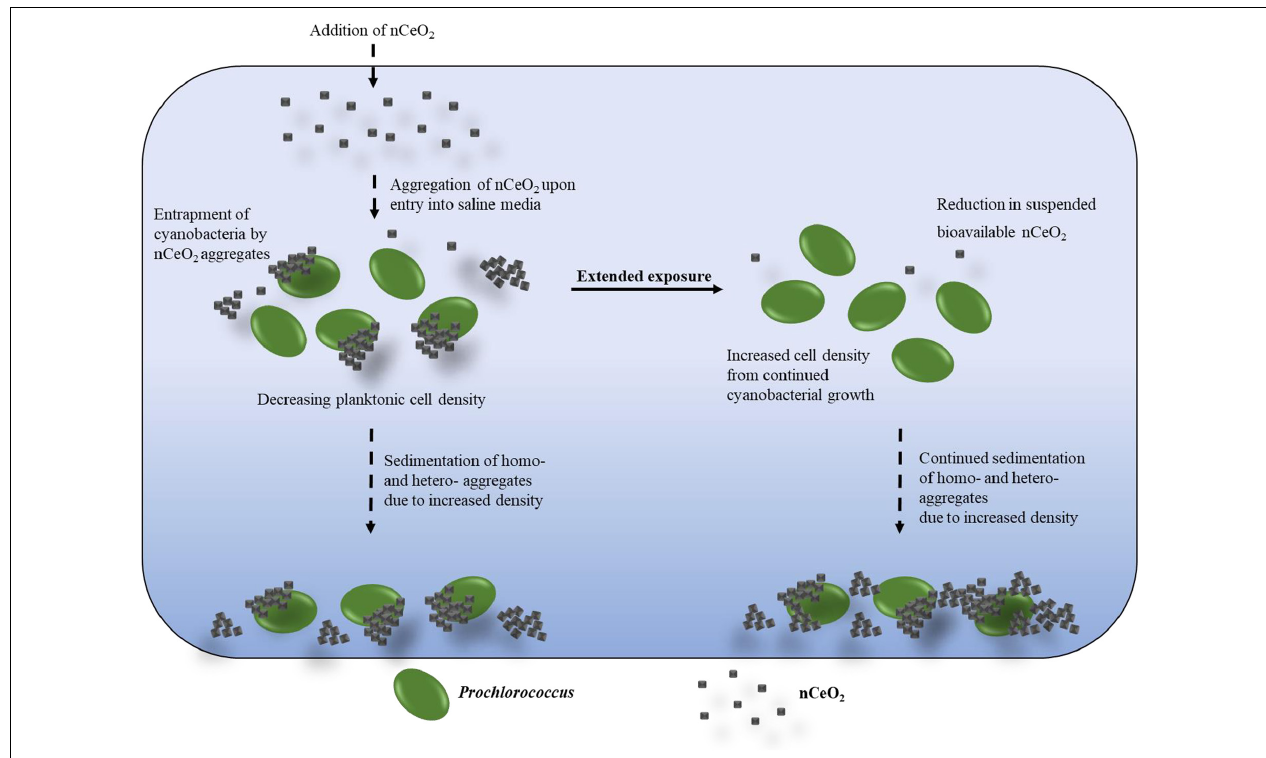
FIGURE 6 | Graphical representation of the proposed mode of cell decline recorded in exposures of Prochlorococcus to nCeO 2